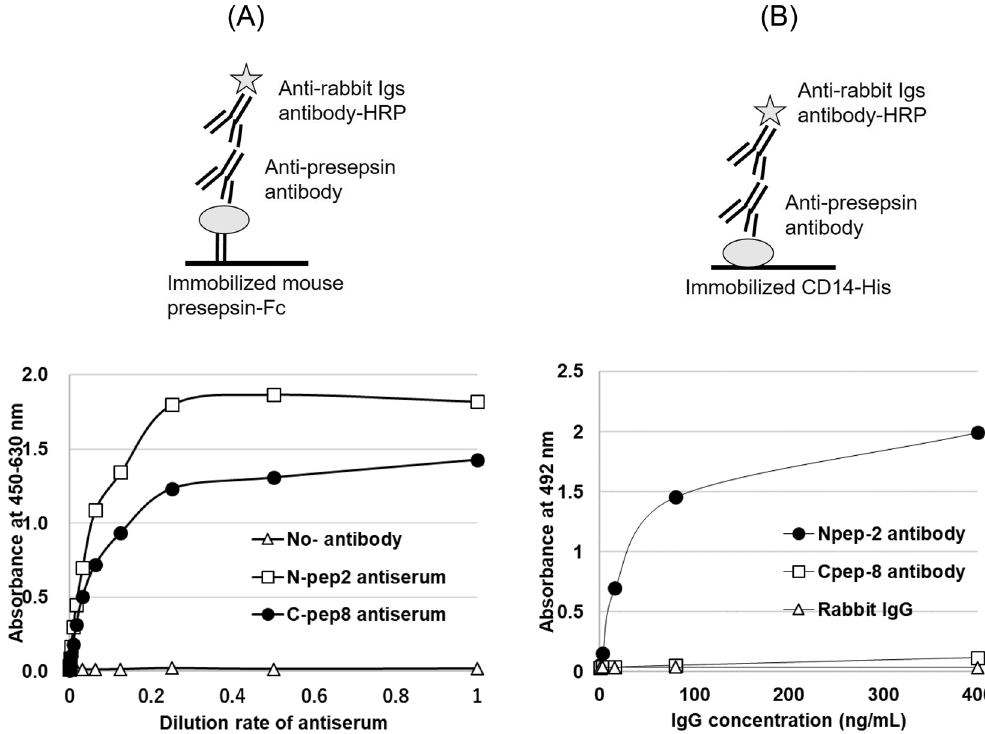
Figure 1. Specificity of the established polyclonal antibodies (N-pep2 and C-pep8) for mouse presepsin as assessed by immobilized antigens. ( A ) Sequential diluted polyclonal antibodies (culture supernatant) were incubated with immobilized recombinant mouse presepsin-Fc (sCD14-ST-Fc) and binding antibodies were detected by peroxidase-labeled anti-rabbit immunoglobulins antibody (DAKO, P0448). Binding activity is shown by the absorbance of 450–630 nm. ( B ) Diluted purified polyclonal antibodies were incubated with immobilized recombinant mouse CD14-His and binding antibodies were detected by peroxidase-labeled anti- rabbit immunoglobulins antibody (DAKO, P0448). Binding activity is shown by the absorbance of 492